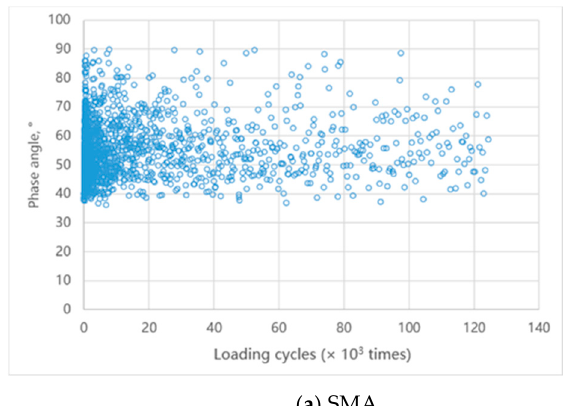
Figure 16. Phase angles of specimens during loading.